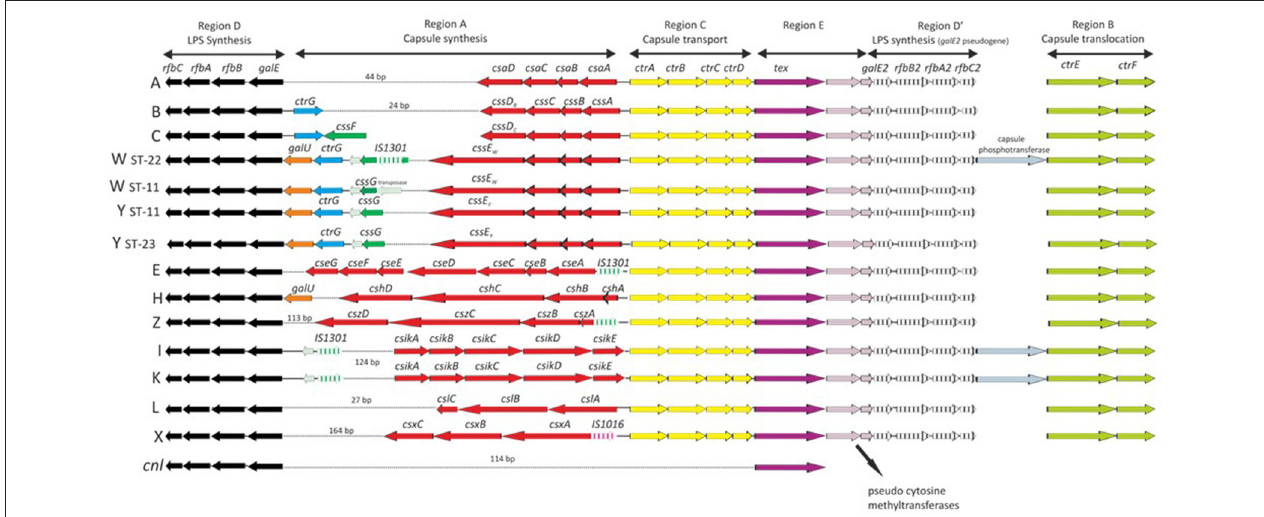
FIGURE 2 | Genetic organization of the cps locus among Neisseria meningitidis serogroups revealed by nucleotide sequencing. Serogroups A ( N. meningitidis isolate Z2491); B (H44/76); C (FAM18, 053442, and 29013); W ( α 275); W (WUE171); Y ( α 162); Y (WUE172); E ( α 707); H (29031); I (29043); K (29046); L (WUE3608); X ( α 388); and Z (WUE173); and a capsule null ( cnl ) isolate. Letters on left represent serogroups. Arrows depict gene orientation. Reproduced without modification from Harrison et al. (43) under CC